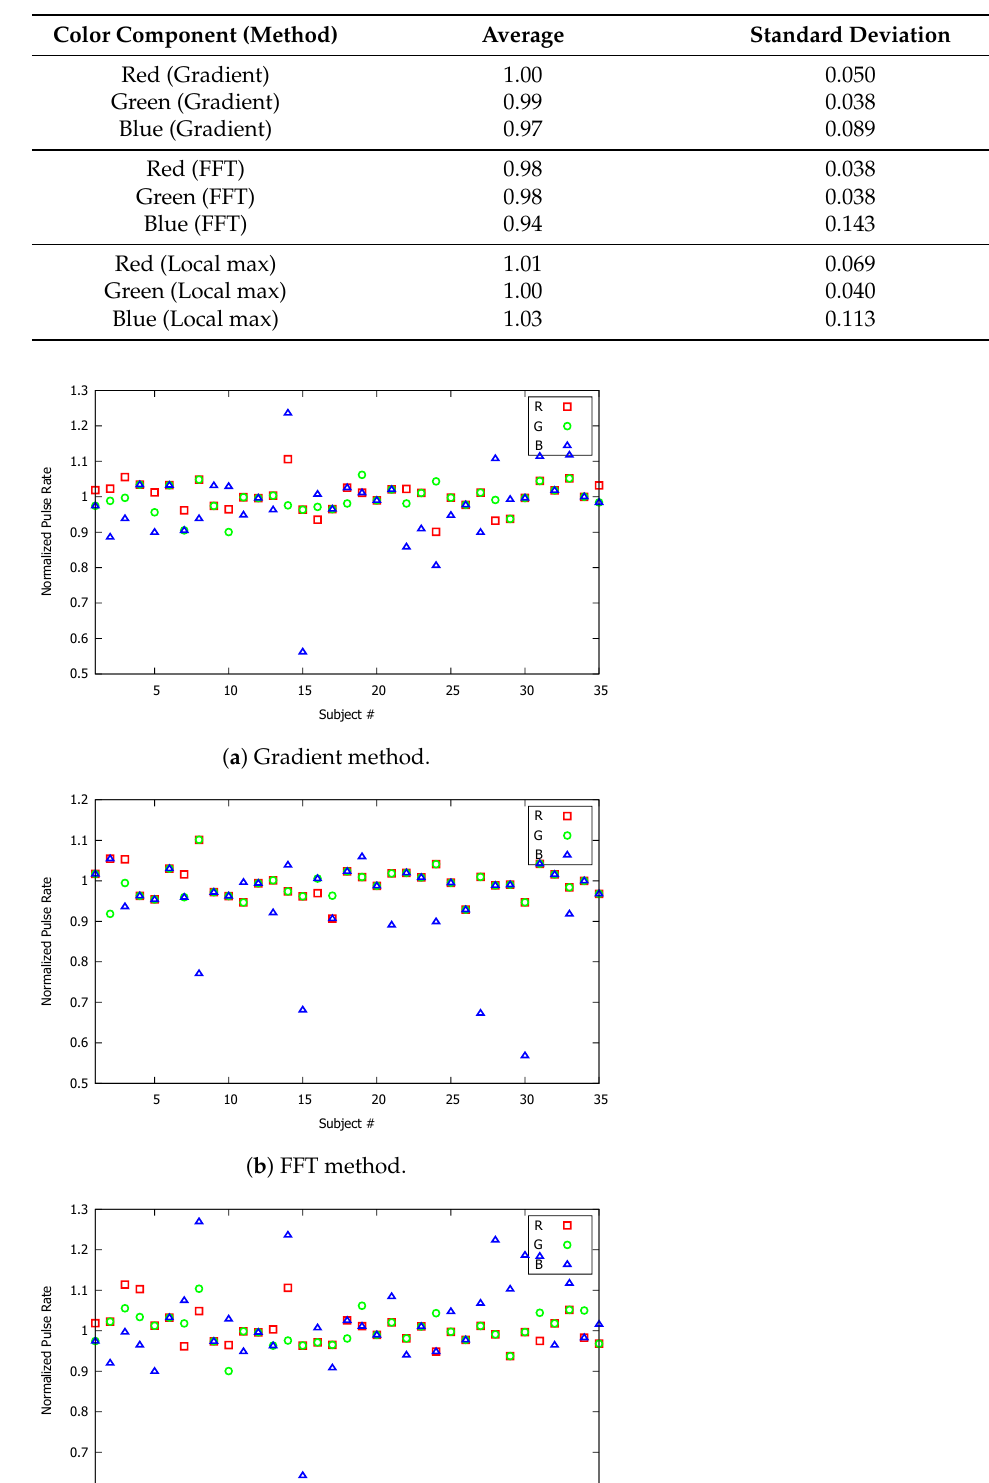
Table 3. Statistical data for 15-s video recordings.